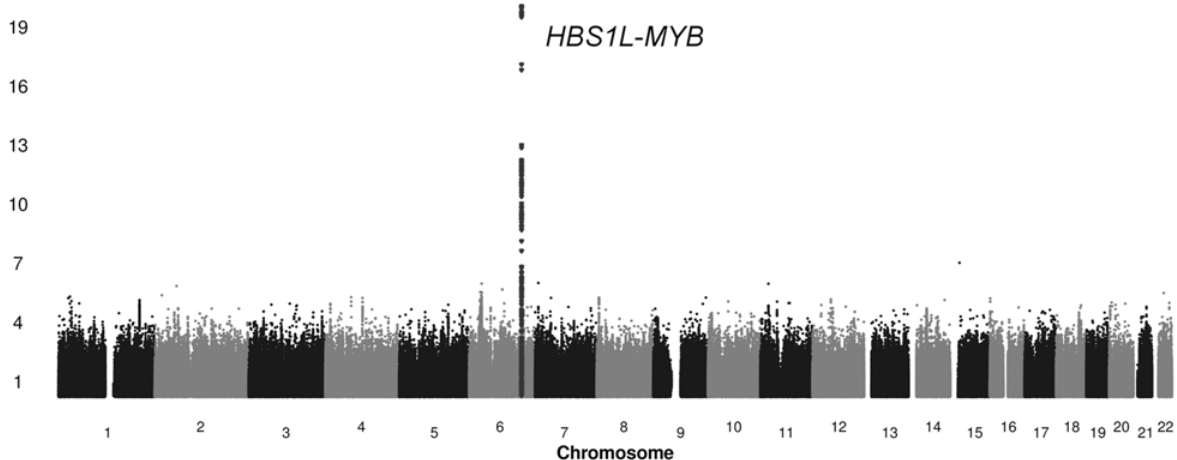
Fig 2. Association of serum erythropoietin with single-nucleotide polymorphisms (SNP). The -10log(P-value) is displayed on the y-axis, a higher value corresponds to a stronger association. Chromosome location is displayed on the x-axis. Each dot represents an individual SNP, the dark grey dots are the SNPs located in locus